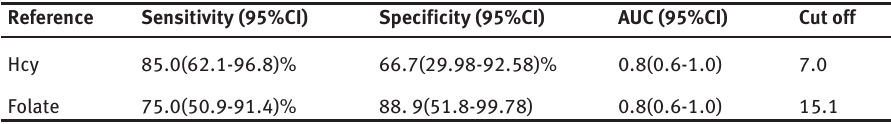
Figure 2: Box plot of serum Hcy and folate comparison between groups. A: Hcy comparison between control and case groups; B:Folate comparison between control and case groups; C: Hcy comparison between the IA and SFP case groups; D: Folate comparison between the IA and SFP groups. Table 5: The prediction efficacy of, serum Hcy and folate for threatened abortion.